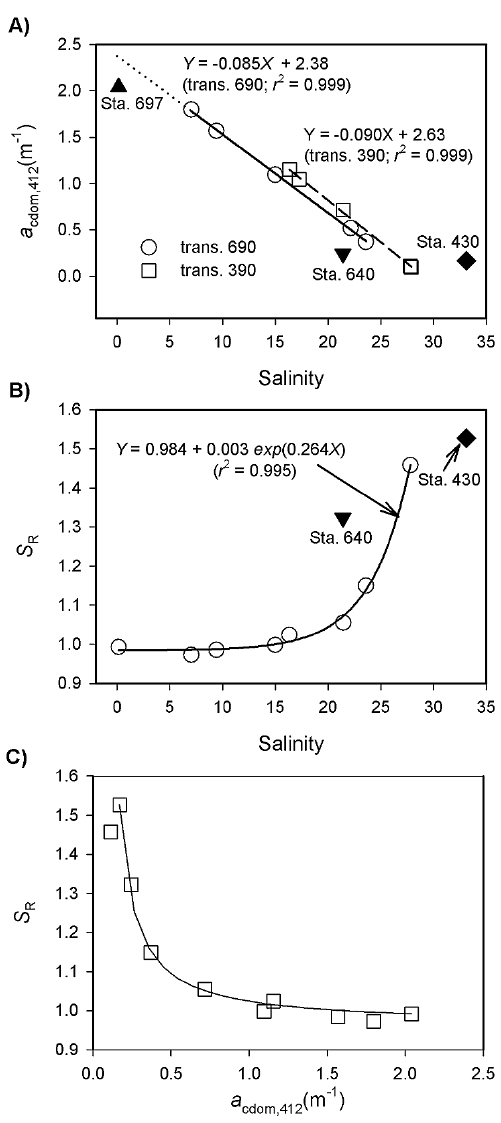
Fig. 3. Plots of CDOM absorption coefficient at 412nm vs. salin- ity (A) and plots of spectral slope ratio vs. salinity (B) and a cdom , 412 (C) . Panel (A) solid and dashed lines are best fits for tran- sects 690 (excluding Sta. 698) and 390, respectively; dotted line is the extrapolation from the solid line. Panel (B) circles represent data combining transects 390 and 690 (excluding Sta. 430 and Sta. 640); line is best fit of circles. Panel (C) line is the conservative mixing line of S R vs. a cdom , 412 using Sta. 697 as the riverine end member and Sta. 430 as the marine end